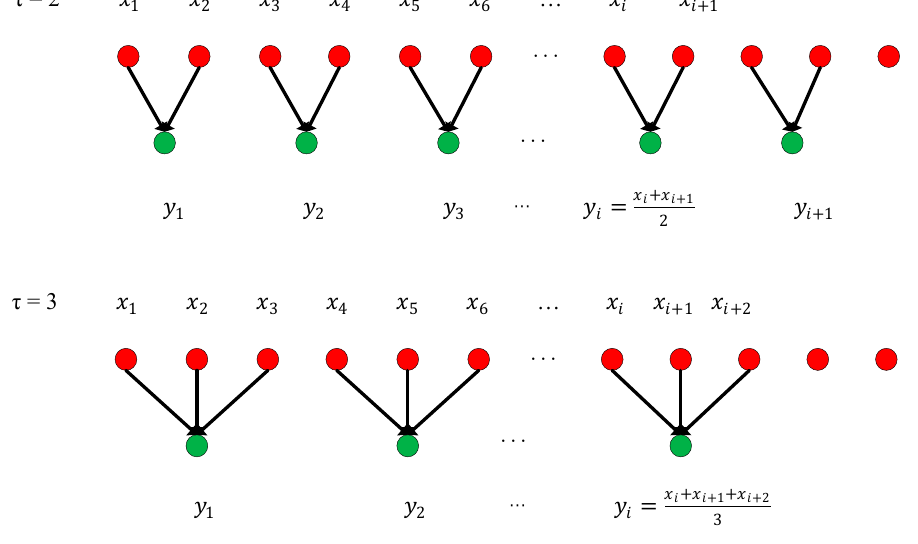
Figure 9. Coarse grain sequences for scale 2 and 3.